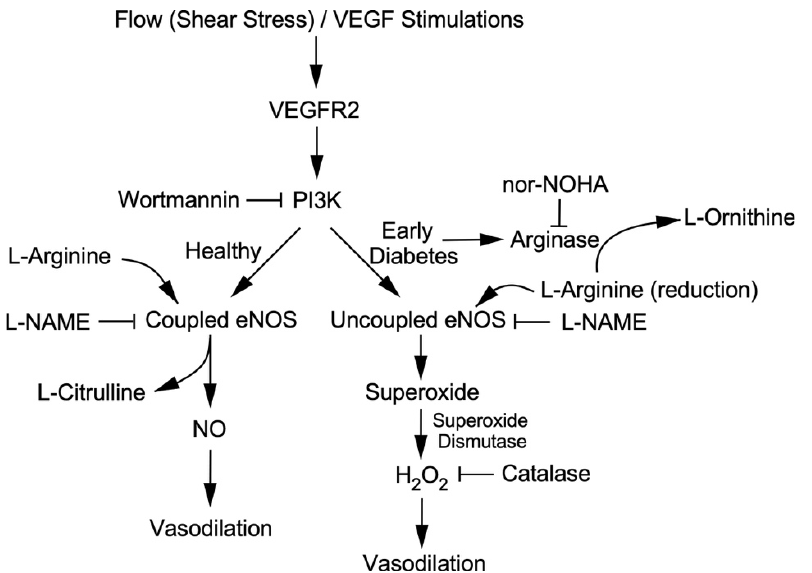
Figure 7. The diagram summarizes the pathways involved in the compensatory generation of H 2 O 2 for NO deficiency in coronary arterioles due to arginase activation in the early stages of type 1 diabetes. L-Arginine is used by eNOS and arginase for the synthesis of NO and L-ornithine, respectively. In healthy coronary arterioles, shear stress and VEGF elicit endothelium-dependent NO-mediated vasodilation via activation of VEGR2/PI3K signaling. In the early stages of diabetes, arginase is activated and competes with eNOS for L-arginine. The reduction in L-arginine availability compromises the production of NO but causes PI3K-linked eNOS uncoupling and consequently promotes superoxide production and H 2 O 2 formation via superoxide dismutase. The compromised NO-mediated vasodilation in early diabetes is compensated by H 2 O 2 . The inhibitors used for probing the signaling pathway are